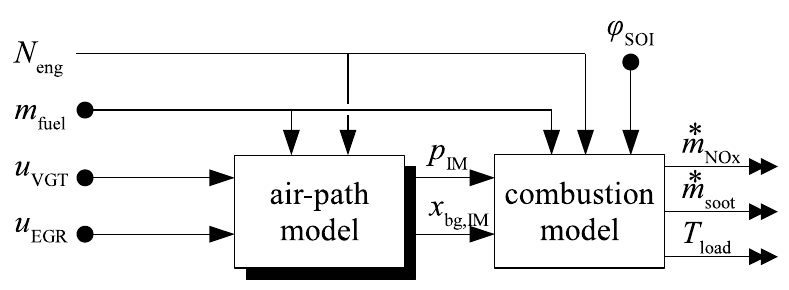
Figure 3. Structure of the engine